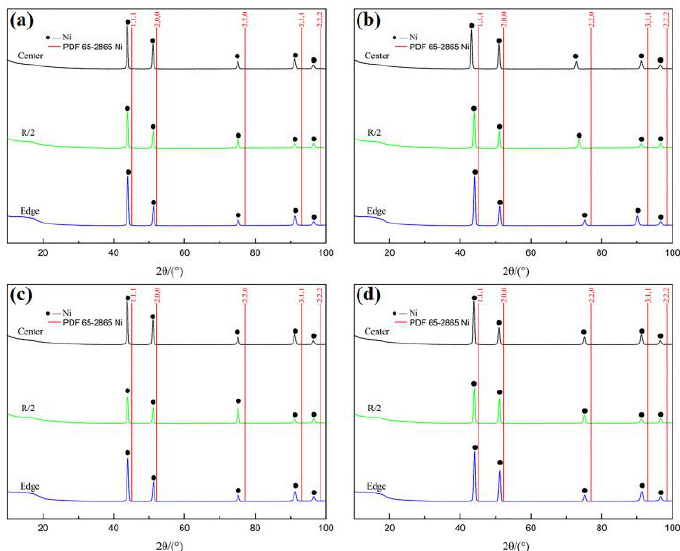
Figure 3. XRD patterns of GH4738 superalloy samples: ( a ) Ingot #1, transverse; ( b ) Ingot #1, longitudinal; ( c ) Ingot #2, transverse; and ( d ) Ingot #2, longitudinal.